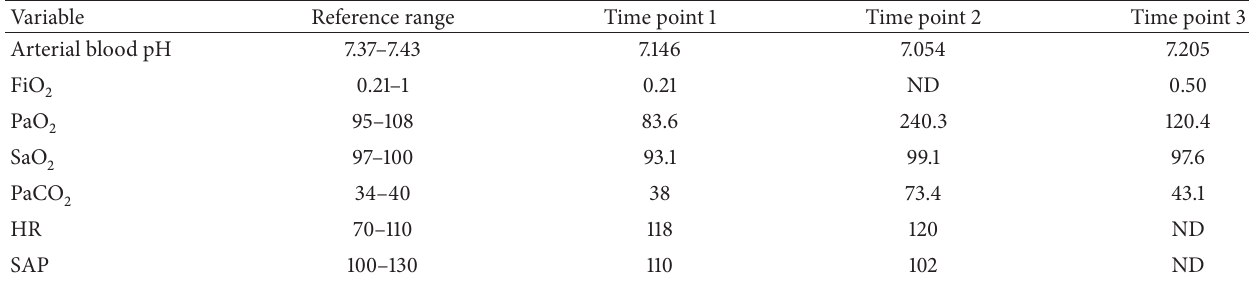
Table 1: Cardiovascular and respiratory variables recorded from an 11-years-old female Yorkshire Terrier during and after an endotracheal stent placement.